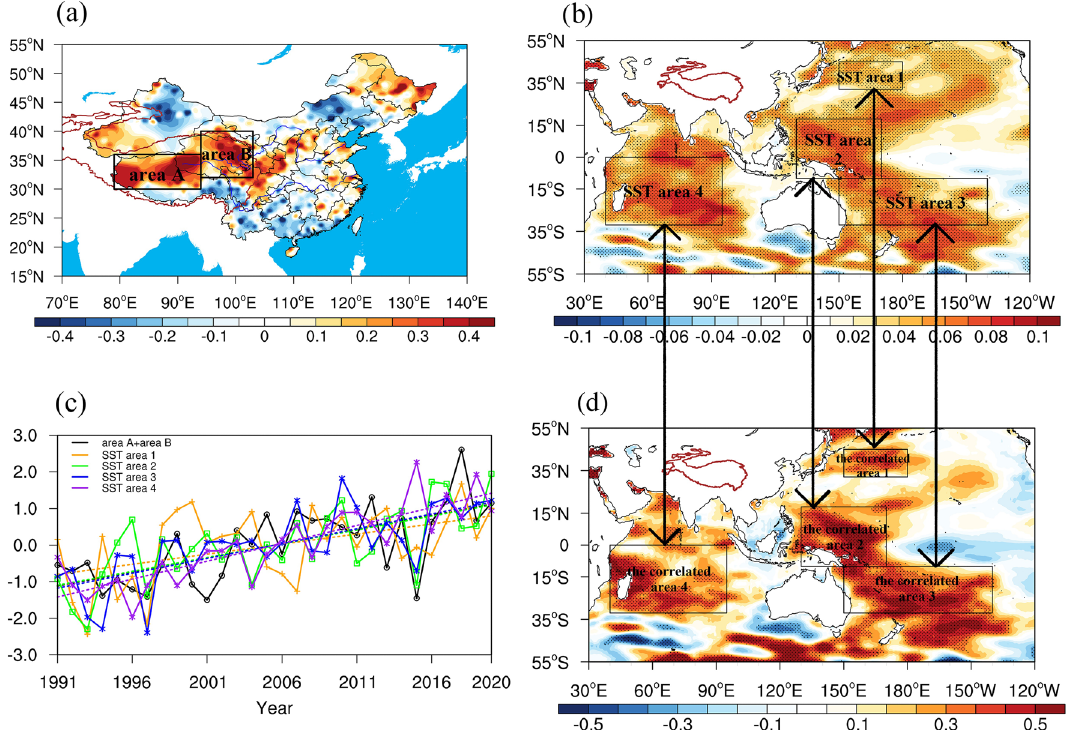
Figure 1. Summer of 1991–2020: ( a ) distribution characteristics of precipitation variability in mainland China (mm/10 year). ( b ) Distribution characteristics of global SST variability (°C/year). ( c ) Interannual variation curves of standardized precipitation in the high-value A and B areas of precipitation variability and standardized SST in high-value areas of SST variability (the correlation coefficients of precipitation and SST area 1, 2, 3, 4 are 0.40, 0.49, 0.61, and 0.49 respectively, dotted line: trend line of precipitation or SST). ( d ) Distribution correlation characteristics between the SST and precipitation in the high-value A and B areas of precipitation variability. (values over the 90% confidence level based on the student t-test are stippled and the color scale represents different values of the correlation coefficients.) The maps were generated with NCAR Command Language (NCL) Version 6.2.1 (http:// www. ncl. ucar.